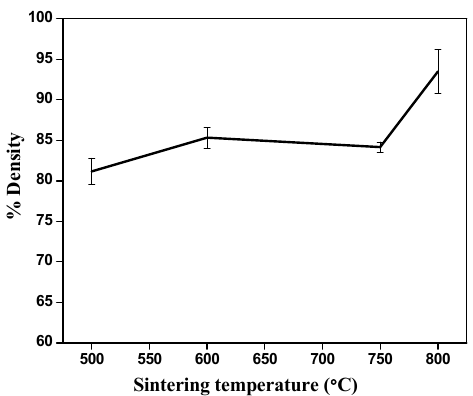
Figure 3. The variation of the density (%) of the BiFeO 3 against sintering temperature.